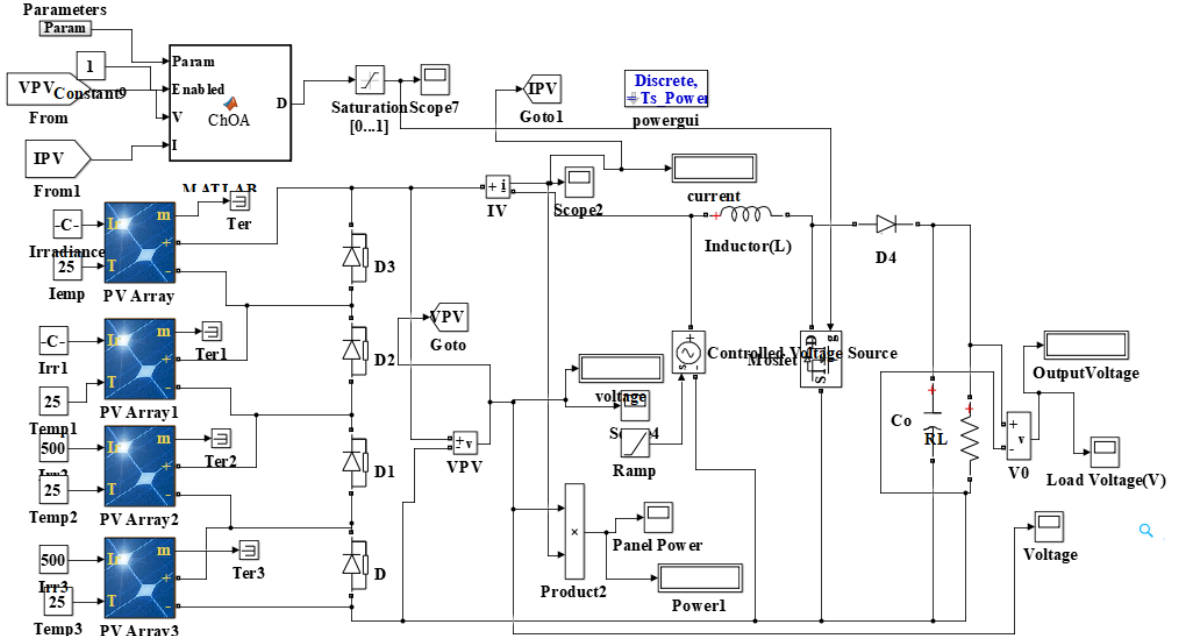
Figure 9. Simulation circuit of KC200GT series-connected PV module under different shading patterns by implementing ChOA algorithm.